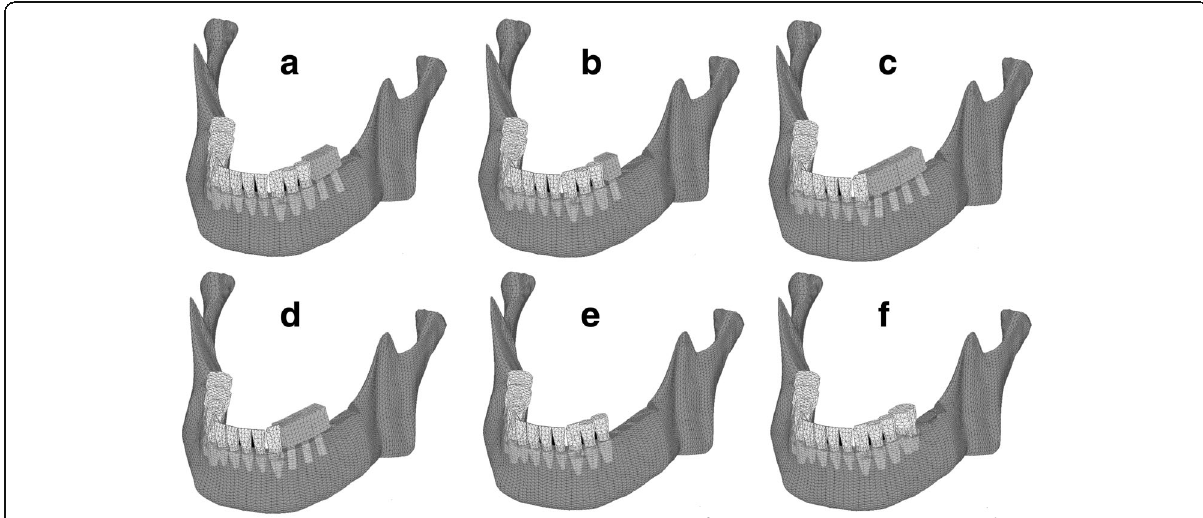
Fig. 1 Three-dimensional finite element model. The tooth roots and implant bodies are displayed with permeability. a Im67, b Im6, c Im4567, d Im456, e MT67, and f